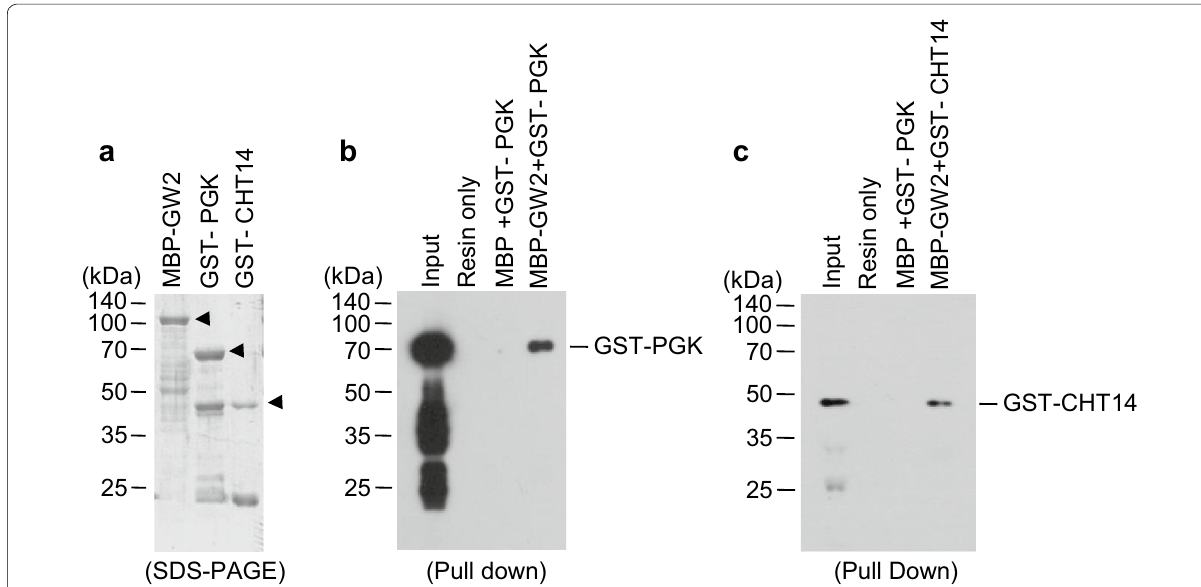
Fig. 2 GW2 interacts with PGK and CHT14. a Recombinant fusion proteins MBP-GW2, GST-PGK, and GST-CHT14 were overexpressed in E. coli and purified using amylose or glutathione resins. Arrowheads indicate MBP-GW2, GST-PGK, and GST-CHT14. b , c In vitro pull-down assay showing the proteins GST-PGK ( b ) and GST-CHT14 ( c ) pulled down with MBP-GW2, separated on 10% SDS–polyacrylamide gels, and detected by western blotting using anti-GST antibody. GST glutathione S -transferase, MBP maltose-binding protein, GW2 grain width 2, PGK phosphoglycerate kinase, CHT14 chitinase 14